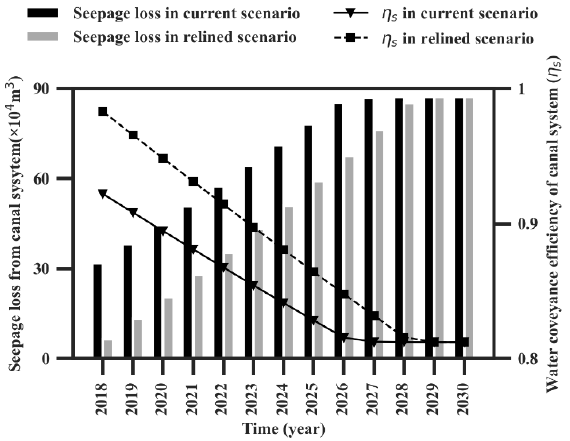
Figure 9. Estimation of seepage loss from canals and water conveyance efficiencies of the canal system η s ) in the reline scenario and current scenario in ( η s ) in the reline scenario and current scenario in 2018–2030. (